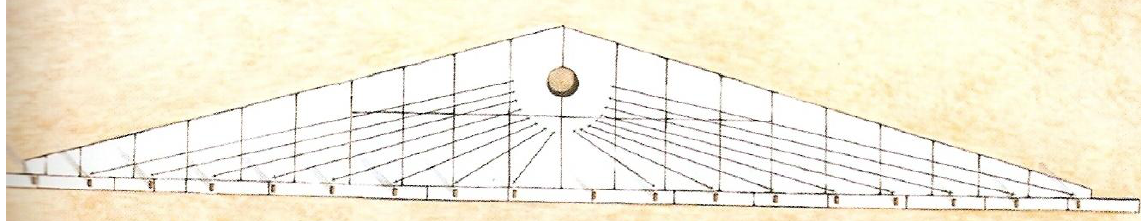
Figura 2- Sistema de partida da Grécia Antiga (ANDRONICOS et al, 2004,